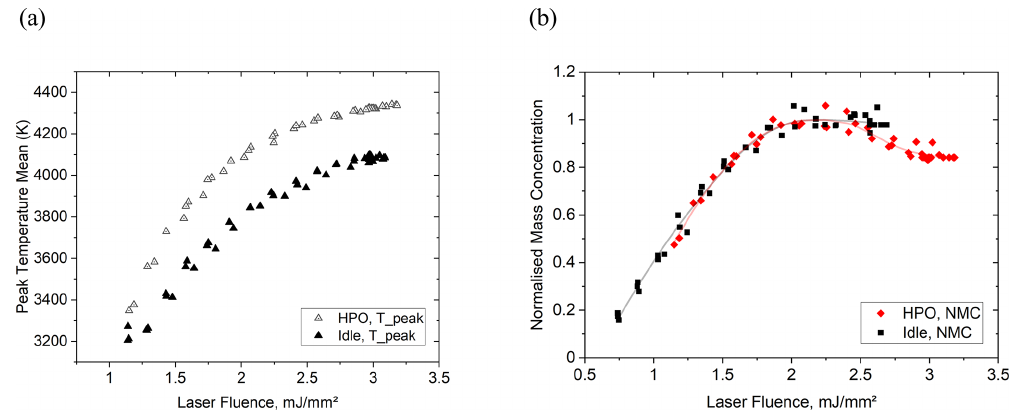
Figure 5. (a) Peak particle temperature mean from the LII 300 for the range of laser fluence levels at the two operating conditions. (b) Shifting of the data in Fig. 4 with the idle condition’s data aligned with that for HPO. NMC (normalised mass concentration) using the nvPM source from the kerosene-fuelled Rig A.